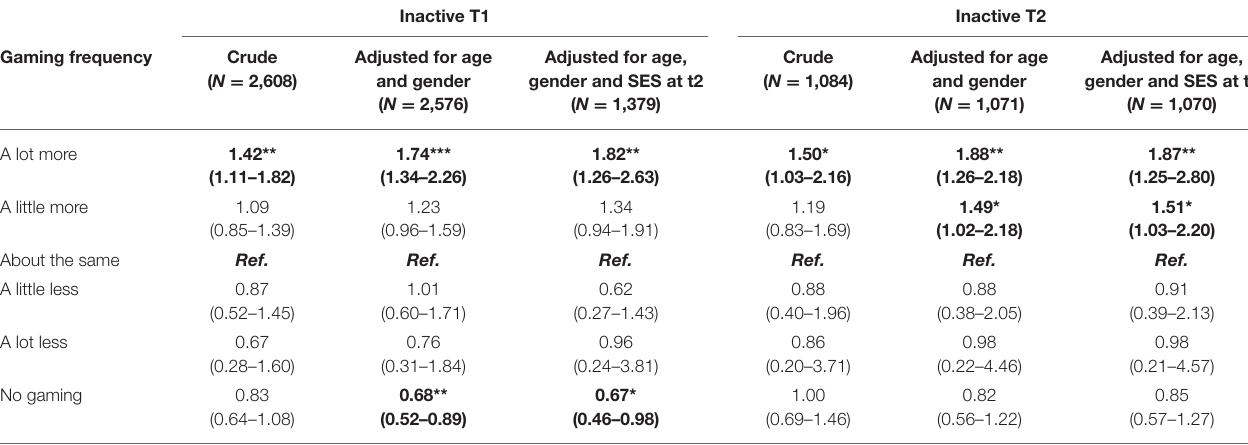
TABLE 3 | Association between categorization of change in gaming and being inactive at first assessment (t1) and second assessment (t2) estimated by logistic regressions. Gaming change over two time